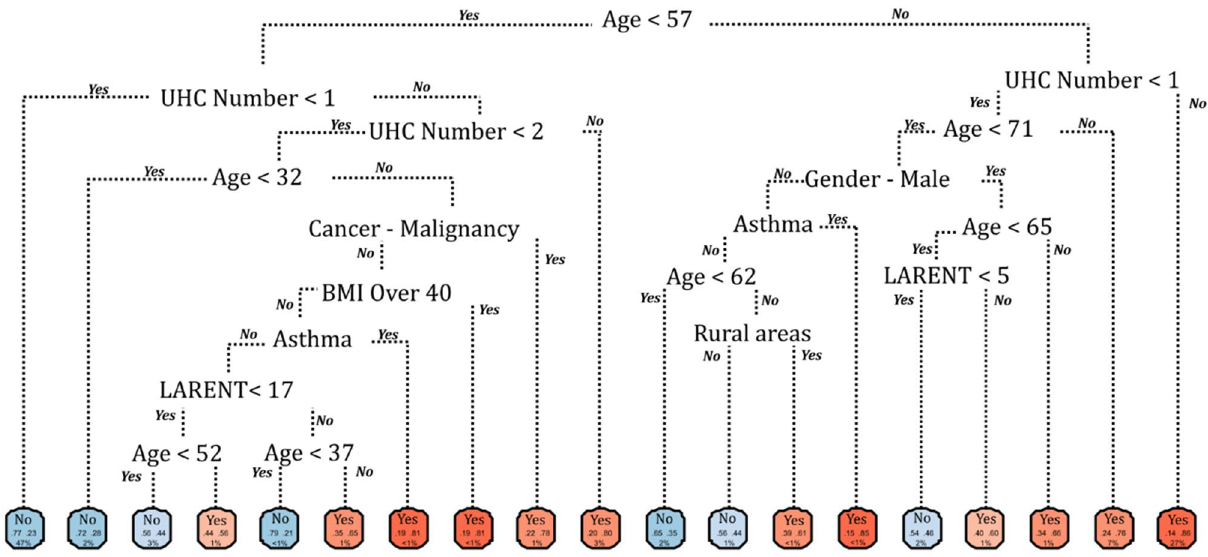
Figure 2. Recursive partitioning and regression tree (rtree) model for hospitalisation among symptomatic COVID-19 cases in the Republic of Ireland, February to November 2020.